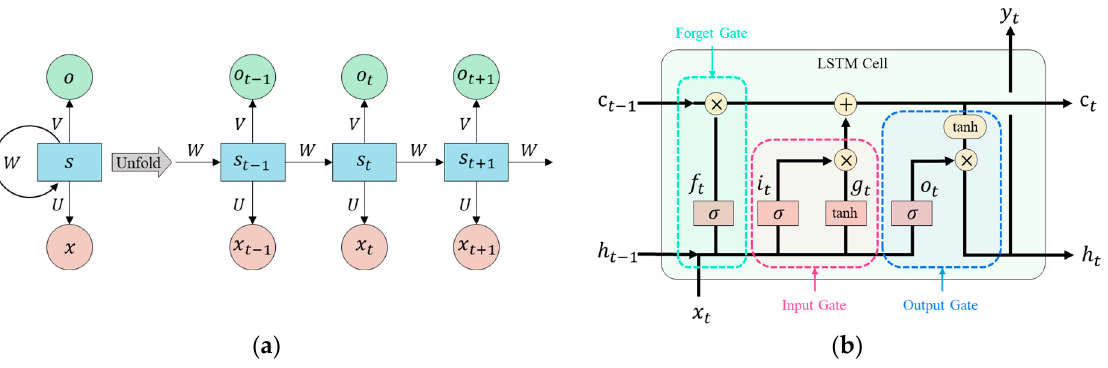
Figure 3. Basic architecture of RNN and LSTM models [33]: ( a ) RNN model; ( b ) LSTM model.